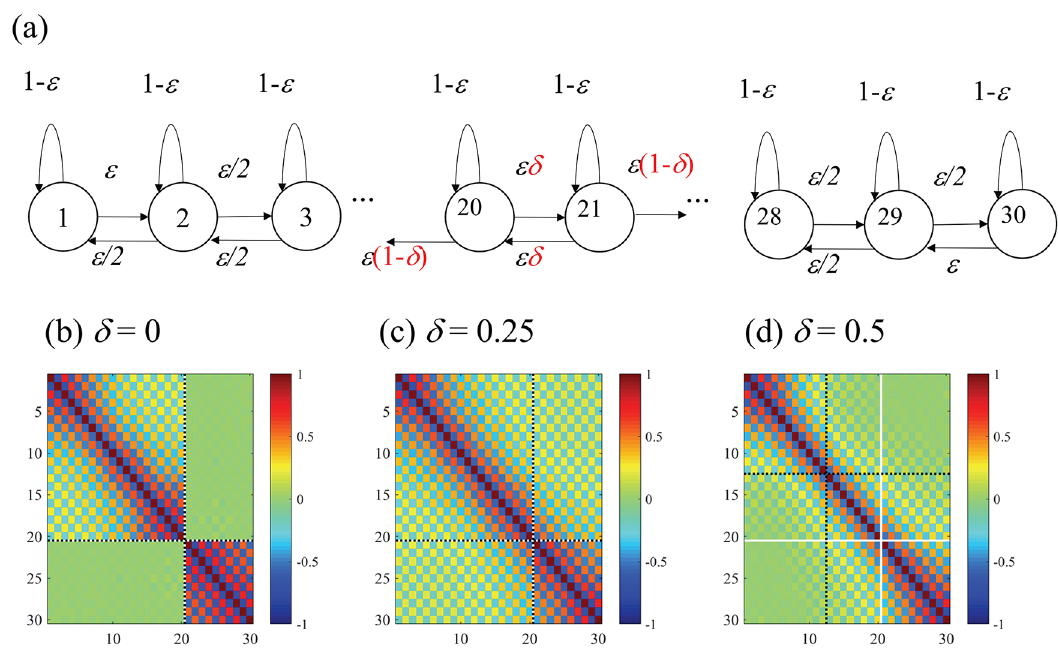
Fig 4. (a) The Coupled Map Lattice model with connection parameter δ indicating the connectivity between variables 20 and 21. The correlation matrices with (b) δ = 0 (disconnected), (c) δ = 0.25 (half-connected), and (d) δ = 0.5 (fully connected). The white crossing lines show the expected partition as the ground truth at which the parameter δ is manipulated, and the black dotted crossing lines show the MIP typically found for each particular